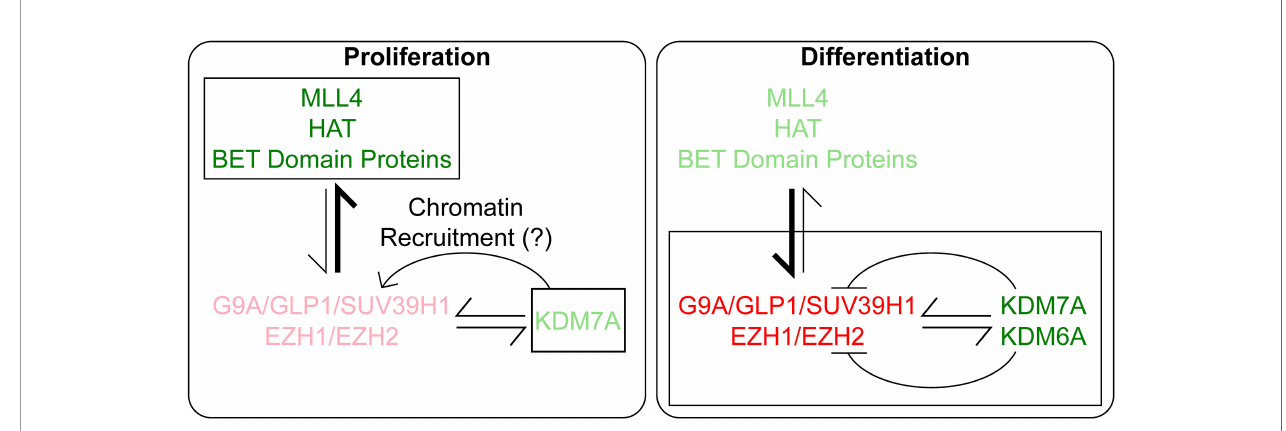
FIGURE 7 | Under Proliferation conditions, Rest transcription is activated by MLL4, HAT and BRD proteins and negatively regulated minimally by PRC2 and demethylase, KDM7A, where we hypothesize it helps in chromatin recruitment of the repressive complexes. In contrast, during differentiation, the repressive complexes G9A and PRC2 play a major role in controlling Rest transcription. At the same time, a lower level of Rest expression is maintained by activating marks and the demethylases KDM6A and KDM7A. The level of action of the proteins are denoted by the boldness of the font, brighter denotes stronger activity and lighter font denotes lower activity.